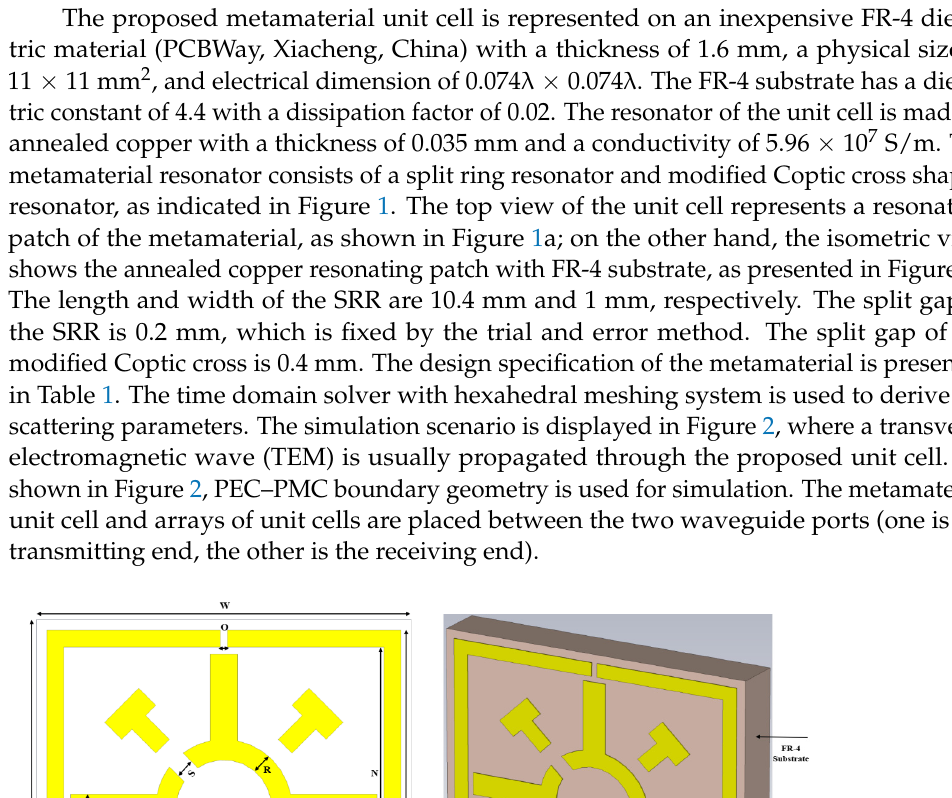
Figure 2. Simulation geometry of the proposed unit cell. Table 1. The design specification of modified Coptic cross shape-based metamaterial. Parameter